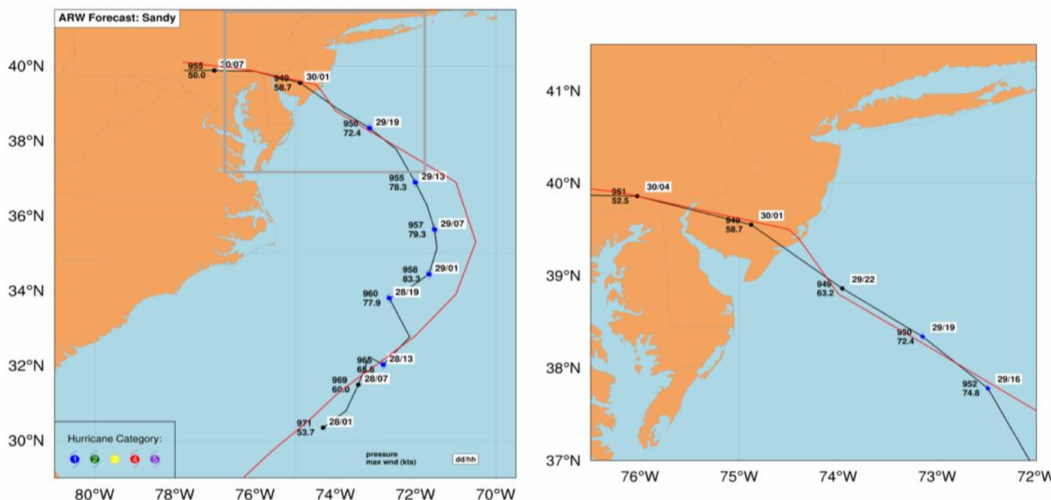
Figure 2. The Weather Research and Forecasting (WRF) model 12-4 km simulated hurricane Sandy track (black) initialized on 28 October 0000 UTC compared to National Hurricane Center (NHC) best track data (red). The simulated storm makes landfall on 30 October at 0000 UTC about 20 km south of hurricane Sandy’s landfall location near Brigantine, NJ, USA. Track information is provided every 6 h. Insert: zoom in view of cyclone landfall location with track information provided every 3 h.